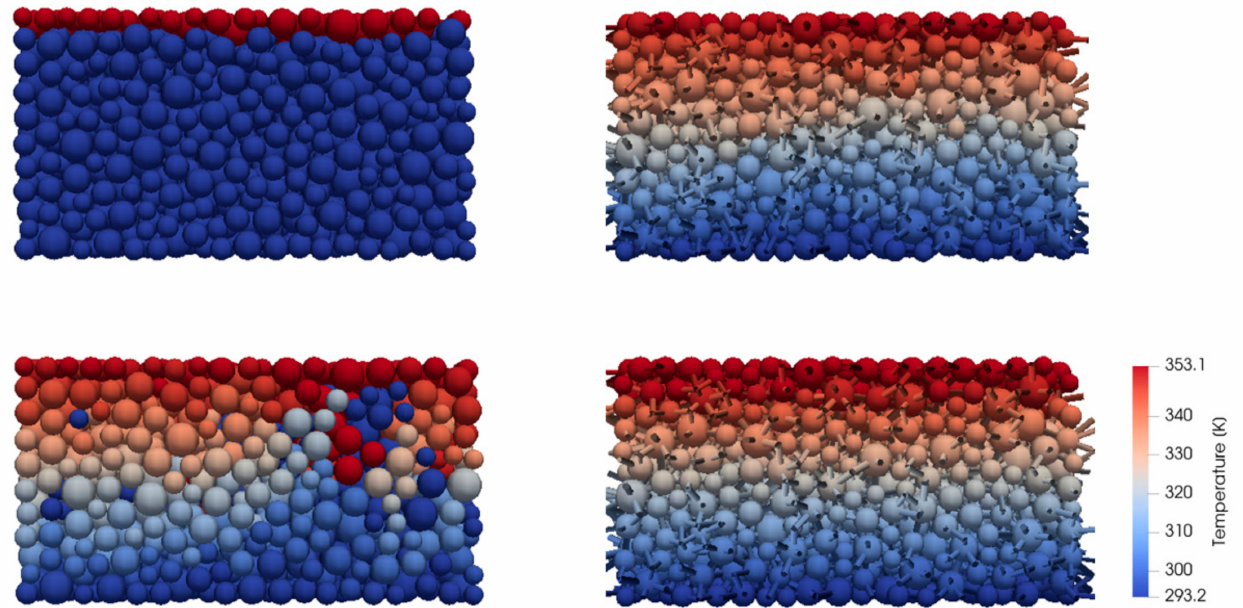
Figure 3. Temperature distribution at a steady state for uncompressed electrodes ( top ); compressed electrodes ( bottom ); using the alter approach ( left ) [13] and using the new approach ( right